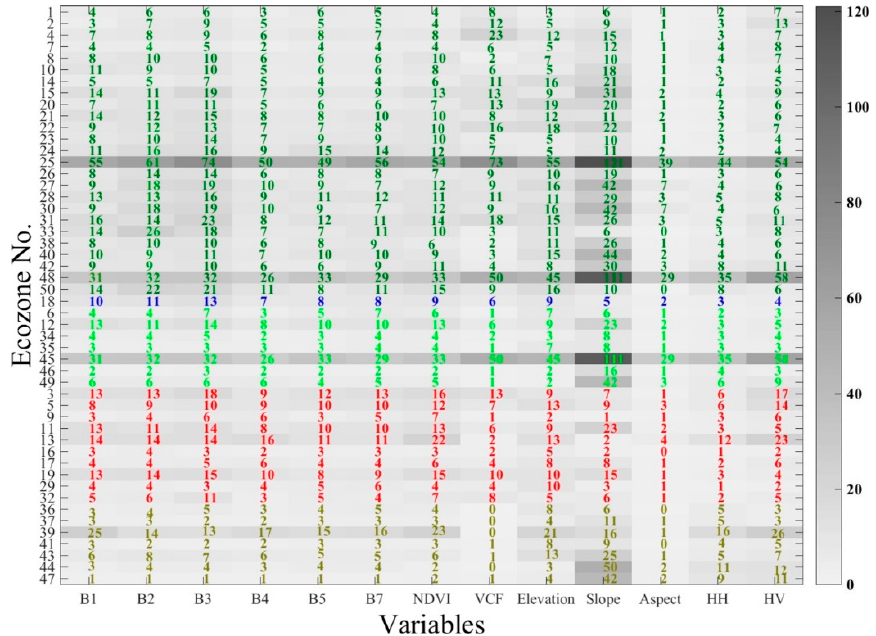
Figure 10. The importance of 13 variables for forest height modeling in each ecozone. The value is the out-of-bag decreased error; the larger the number is or the darker the color is, the more important the variable is. Colors of numbers indicate different ecozones, with dark yellow signifying desert, red representing agriculture, light green representing grassland, olive indicating forest, and blue representing a special ecozone in the Three Gorges Reservoir.